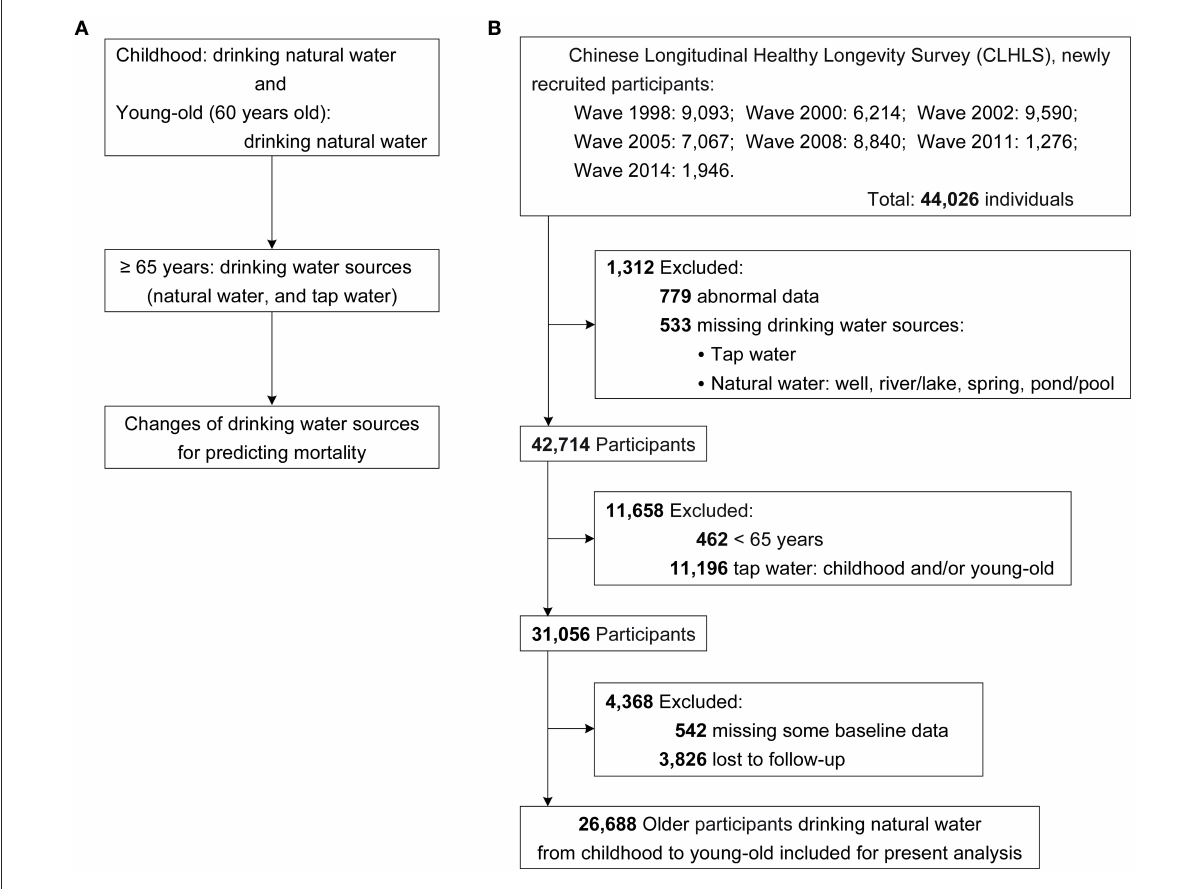
FIGURE1 Flow chart. (A) study design, (B) participants selection diagram.